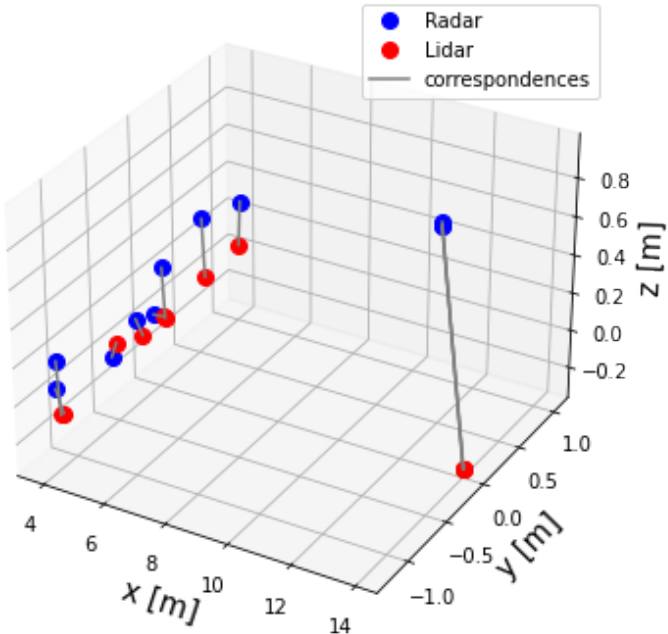
Figure 12. Lidar and radar pointsets before correction.